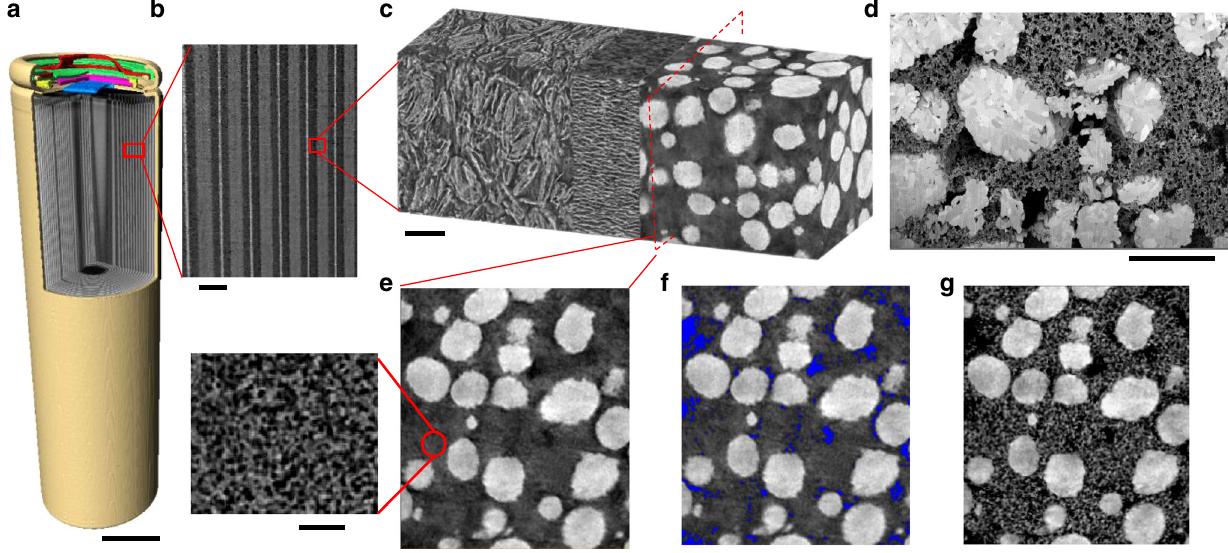
Fig. 1 Hierarchical structure of the LiB. a Volume rendering of the reconstructed cylindrical battery scanned by X-ray micro-CT (accelerating voltage 180 kV, exposure time 1 s and voxel size 12.9 μ m). The metal shell (brown), top button (red), venting disk (green), crimp plate (pink), seal insulator (yellow) and current collector (blue) are shown, with a corner cut displaying the internal structure of the battery; b magni fi ed virtual slice to show the periodic layered structure of the cell; c X-ray nano-CT image showing (from left to right) the graphite anode, polyole fi n separator and NMC cathode; d SEM image showing the CBD morphology alongside the secondary NMC particles, wherein the crystallography of the primary particles is seen; e virtual slice of the reconstructed 3D electrode, showing a blurry phase comprising the CBD and micro-pores (white: active material particles; dark grey: macro-pores; light grey: blurry mixed phase of micro-pores and CBD). Inset image shows the higher resolution scan of the CBD phase; f macro-pores (blue) are highlighted and retained with the active particle in the dual-scan superimposition process; g the resultant full microstructure of the NMC cathode by X-ray CT. The scale bars in ( a , b ) represent 10 mm and 240 μ m respectively, 10 μ m in ( c , d , e ) and 2 μ m in the inset of ( e